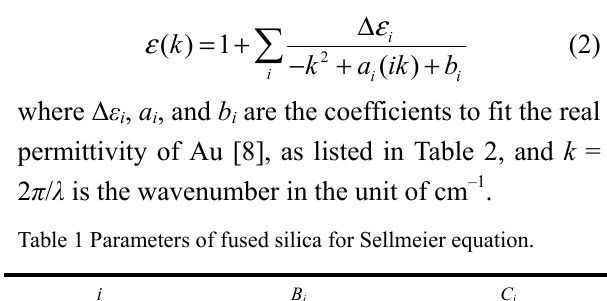
Fig. 1 Structure and device performance of the QDs/Au sensors: (a) schematic of the PCF RI sensor coated with the Au and QDs film in the central holes and (b) loss spectra of the core mode for a QDs/Au sensor and an Au sensor. Inset: electric field distributions for the Au sensor at 425 nm and 525 nm (resonance wavelength), and for the QDs/Au sensor at 660 nm (resonance wavelength) and 725 nm with n a = 1.30.